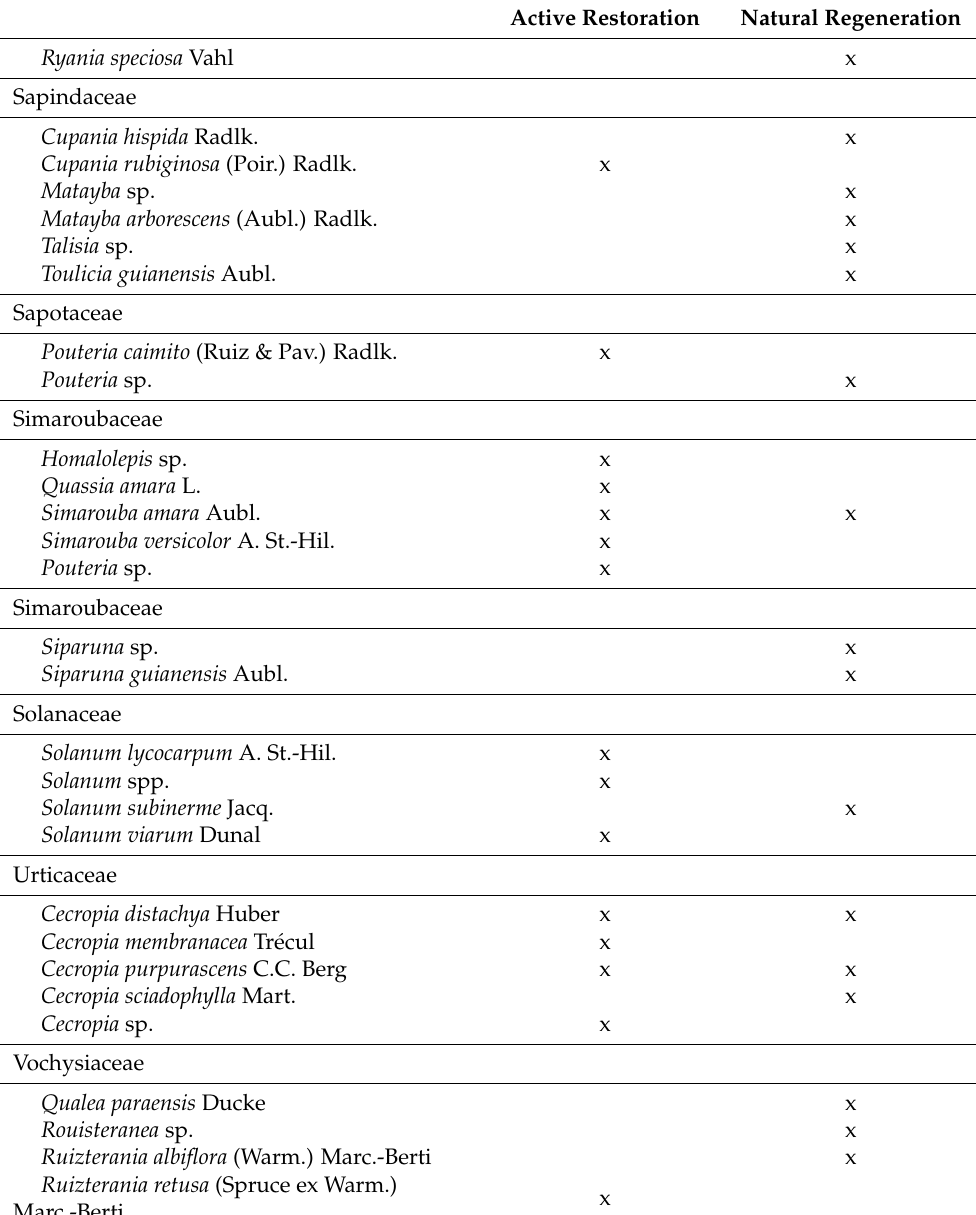
Table A2. Cont. Active Restoration Natural Regeneration Ryania speciosa Vahl x Sapindaceae Cupania hispida Radlk. x Cupania rubiginosa (Poir.) Radlk. x Matayba sp. x Matayba arborescens (Aubl.) Radlk. x Talisia sp. x Toulicia guianensis Aubl. x Sapotaceae Pouteria caimito (Ruiz & Pav.) Radlk. x Pouteria sp. x Simaroubaceae Homalolepis sp. x Quassia amara L. x Simarouba amara Aubl. x x Simarouba versicolor A. St.-Hil. x Pouteria sp. x Simaroubaceae Siparuna sp. x Siparuna guianensis Aubl. x Solanaceae Solanum lycocarpum A. St.-Hil. x Solanum spp. x Solanum subinerme Jacq. x Solanum viarum Dunal x Urticaceae Cecropia distachya Huber x x Cecropia membranacea Tr é cul x Cecropia purpurascens C.C. Berg x x Cecropia sciadophylla Mart. x Cecropia sp. x Vochysiaceae Qualea paraensis Ducke x Rouisteranea sp. x Ruizterania albiflora (Warm.) Marc.-Berti x Ruizterania retusa (Spruce ex